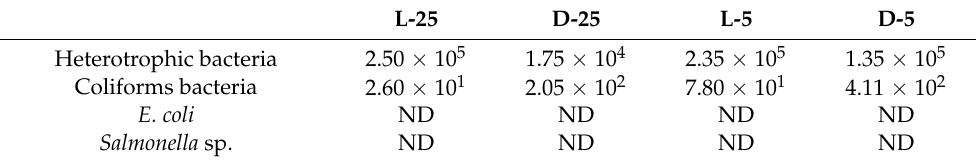
Table 2. Microbial population counts during the experiments. Data are expressed as CFU·L −1 .